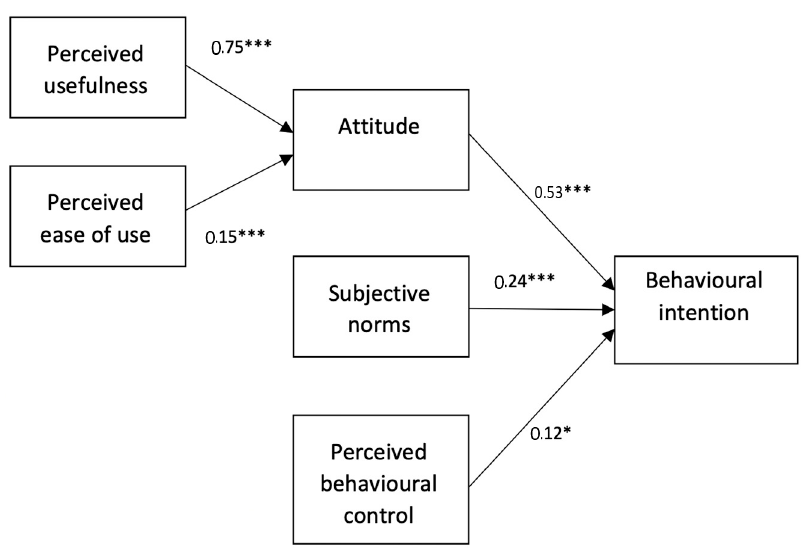
Figure 2. Main effects model. Note. * p < 0.05; *** p < 0.001.